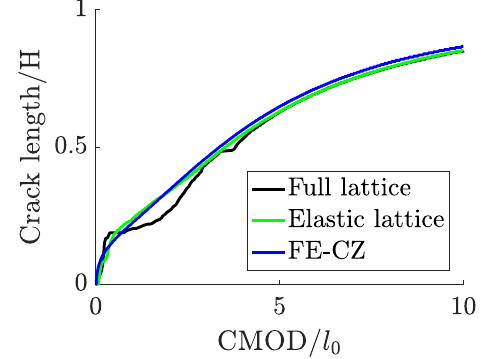
Figure 8. Normalized crack length as a function of crack mouth opening displacement (CMOD) computed for the ductile material